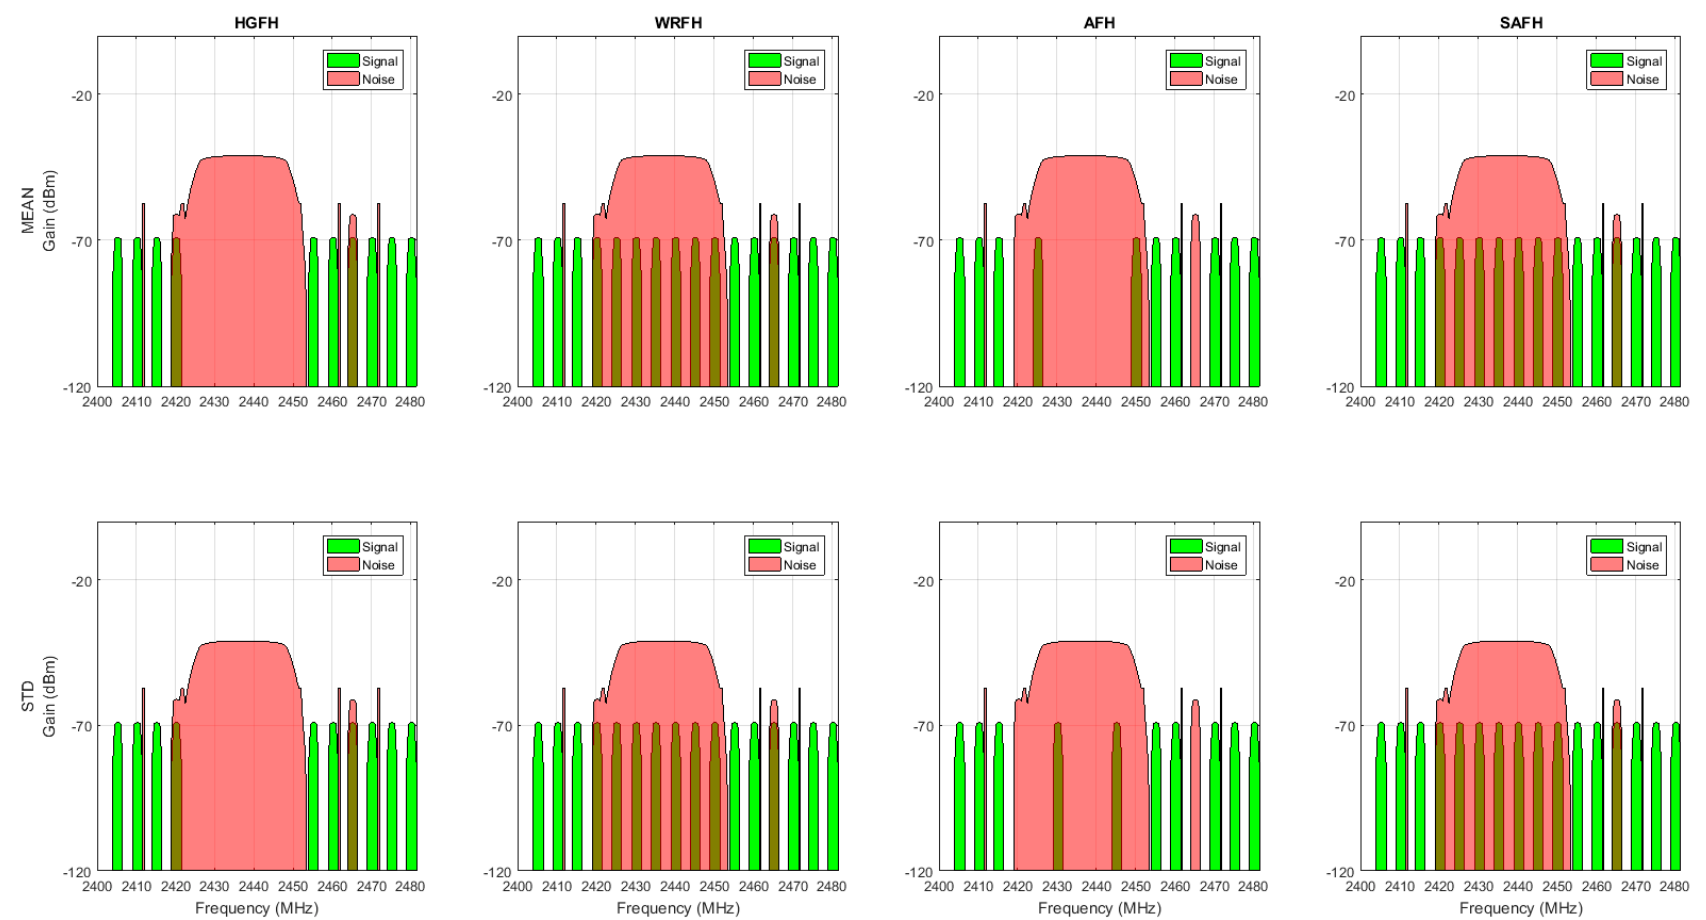
Figure 21. Strength of signal and noise for different hopping techniques and quality metrics. The interfering noise is represented in red and the signal of interest in green. The noise is the sum of all the interfering networks as received at the gateway. The signal of interest is the signal strength received at the gateway coming from the first node.